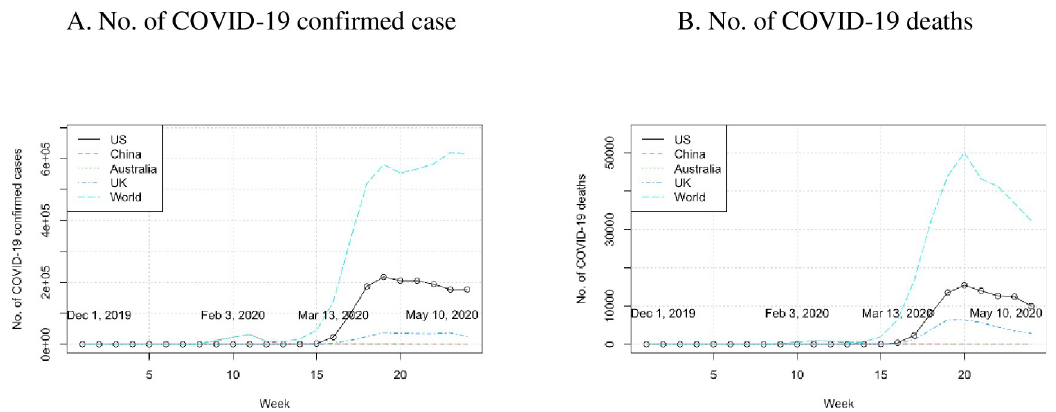
Fig 2. Weekly number of COVID-19 confirmed cases and